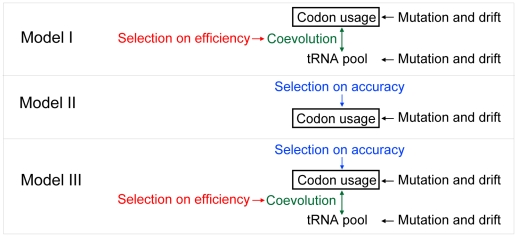
Evolutionary models of synonymous codon usage bias.Three models that differ in the involvement of natural selection for translational accuracy and efficiency in the evolution of codon usage bias. Models I and II can be rejected by the existing data, whereas model III is supported by available data.